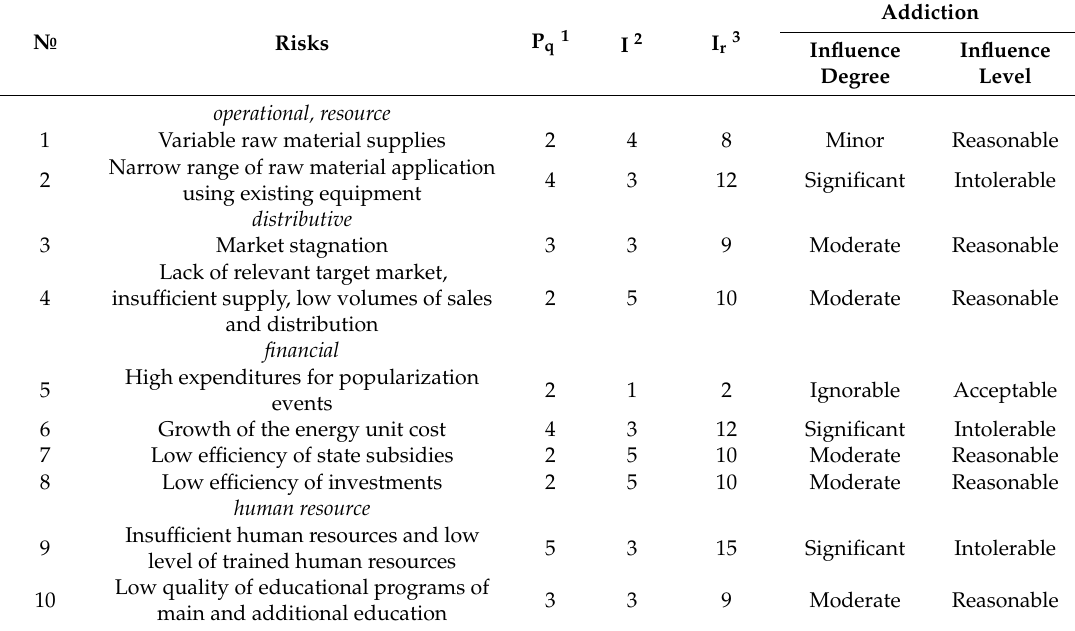
Table 1. Assessment of potential risks of biofuel production in